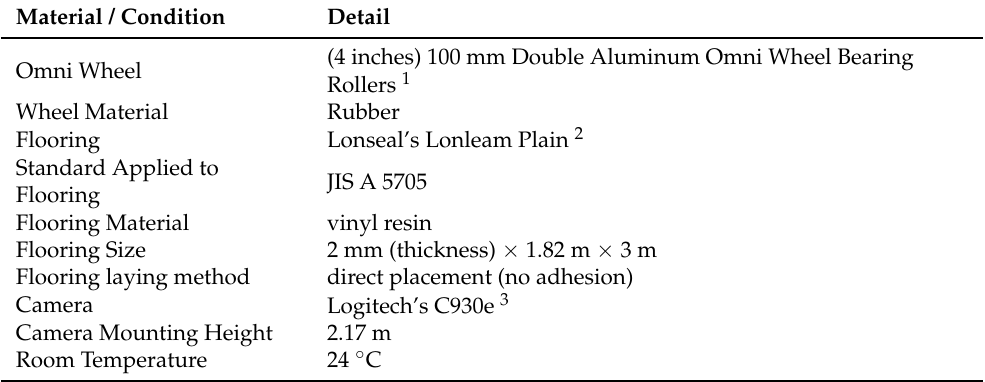
Table 1. The materials and conditions used in the